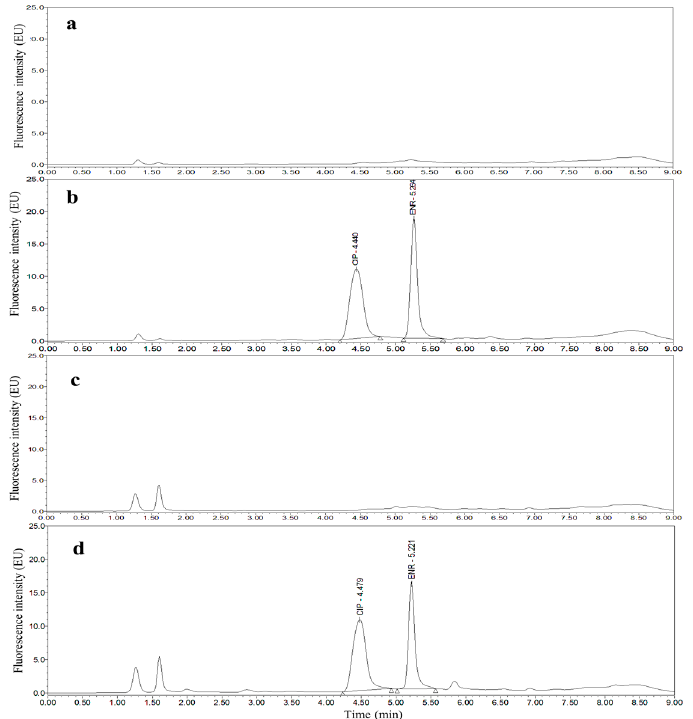
Figure 2. Chromatograms of the mobile phase ( a ), 50 μ g/kg CIP and 25 μ g/kg ENR standards ( b ), blank blended whole chicken egg ( c ) and blank blended whole chicken egg spiked with 50 μ g/kg CIP and 25 μ g/kg ENR standards ( d ) from channel B.